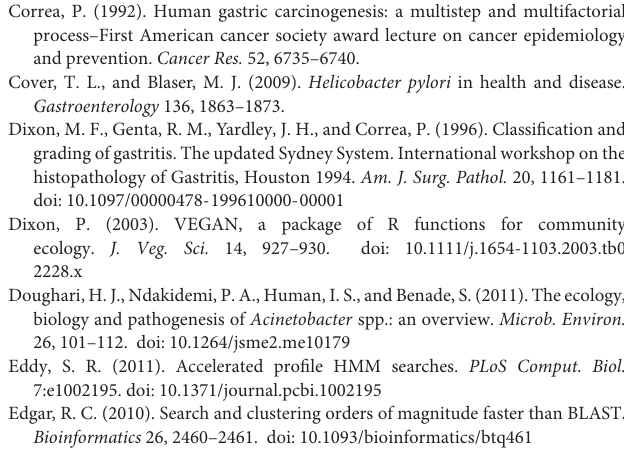
Supplementary Figure 4 | Gastric corpus mucosa-associated microbiome changes by H. pylori infection. LEfSe analyses showed an increase in Proteobacteria abundance and a decrease in Actinobacteria, Sphingomonadales, Prevotella , and Veillonella abundance (A) . Alpha-diversity indices were significantly decreased in H. pylori- infected patients (B) . Supplementary Figure 5 | Summary of the linear discriminant analysis (LEfSe) comparing Group 1 with Group 4. The figure shows significantly different taxa